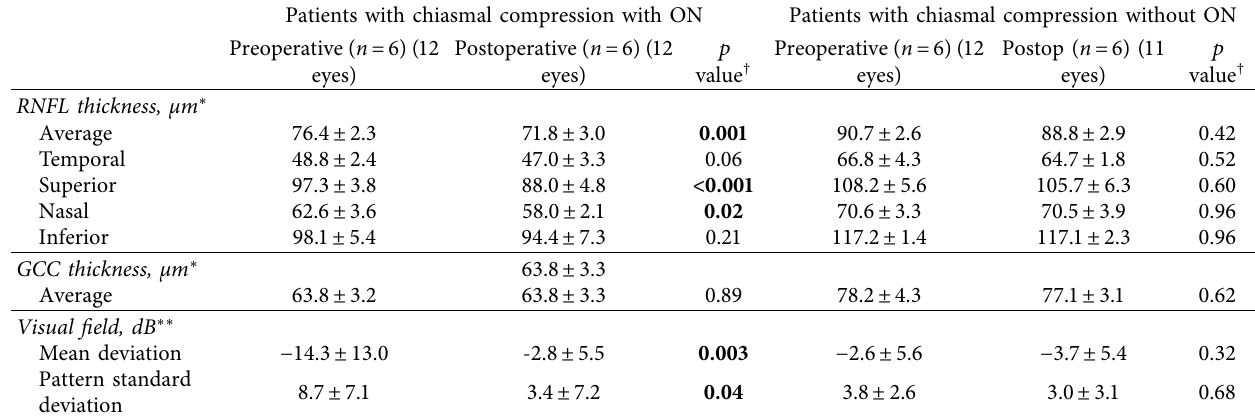
Table 2: Structural and functional characteristics of patients with chiasmal compression. Patients with chiasmal compression with ON